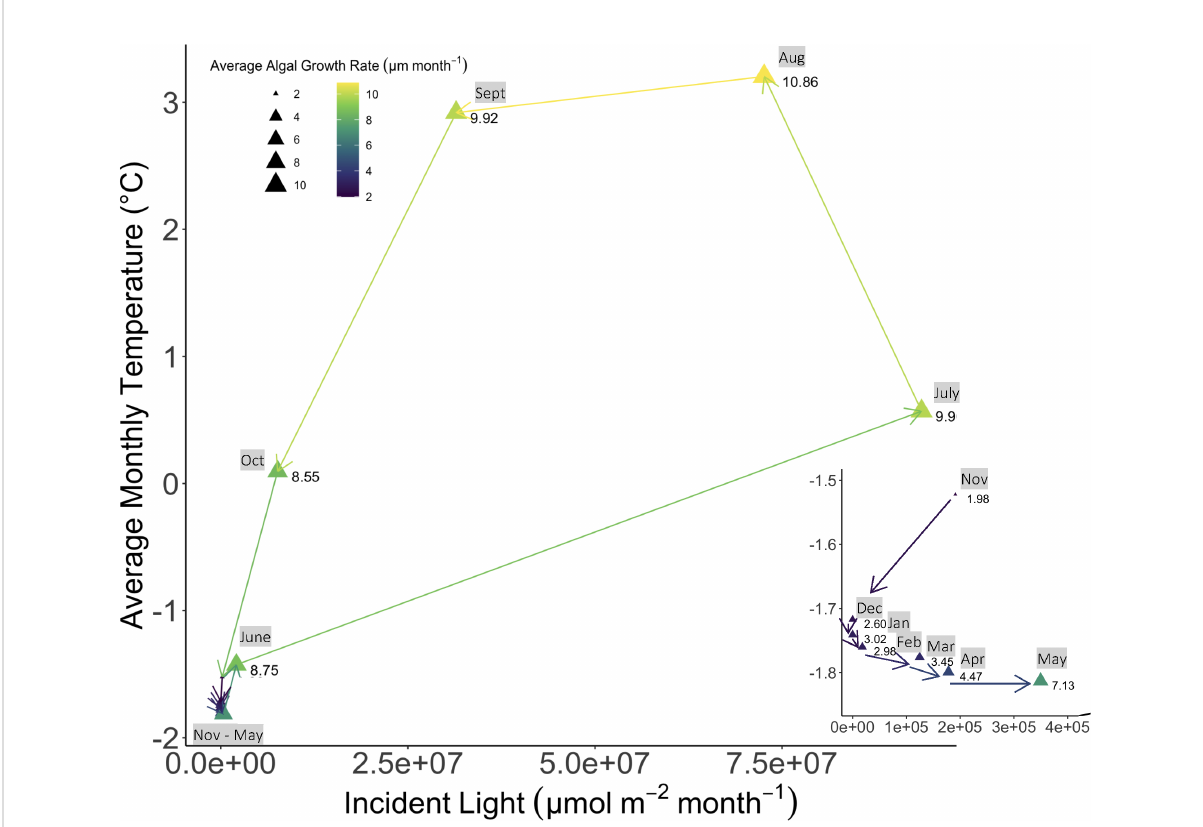
FIGURE 9 Average monthly temperature (°C) and incidence light energy (µmol photon m -2 month -1 ) trajectory for the Arctic Bay, NU experimental array colour and size indicate average modeled algal growth rate (µm month -1 ). Small inlay fi gure shows growth rates from November through the month of May. Black numbers beside each point also indicate average modeled algal growth rate (µm month -1 ).